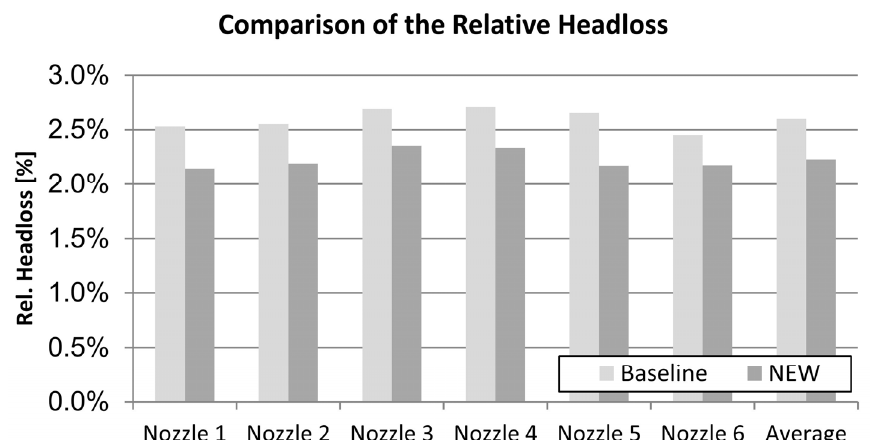
Figure 10. Comparison of the relative headloss